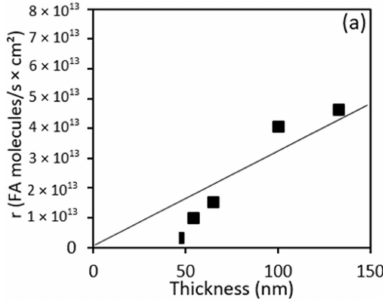
Figure 4. Disappearance rate of FA as a function of the photons absorbed.